Question: In a single sentence, describe what this figure presents.
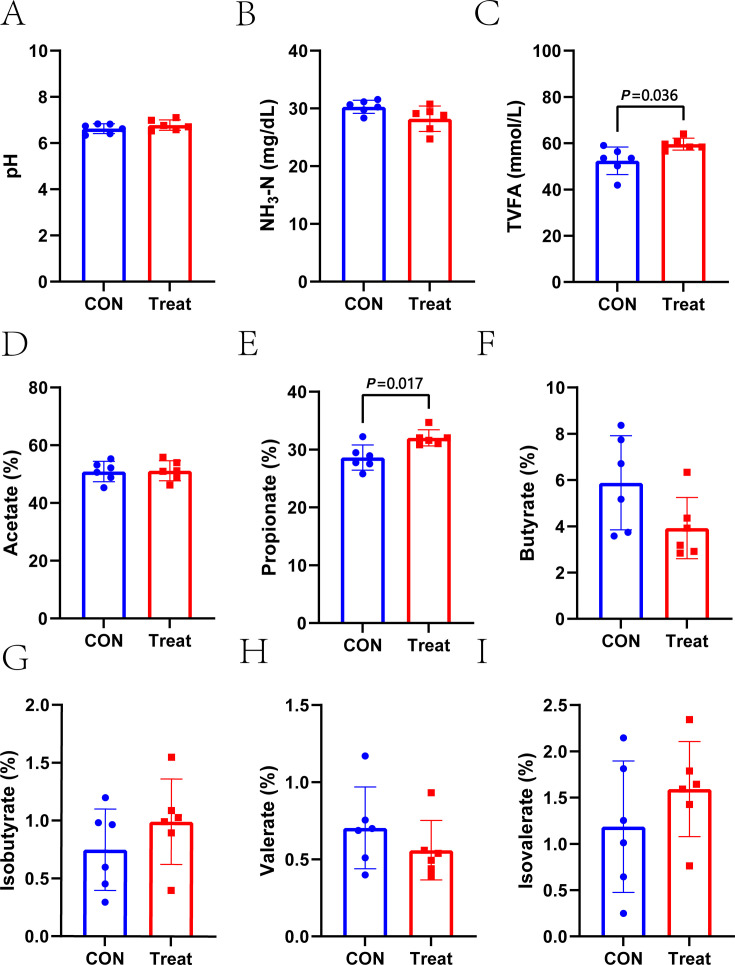
Answer: Effects of supplemental fermented Chinese herbal medicine on rumen fermentation parameters in lambs. Data are presented as mean ± SEM. Group comparisons were analyzed using an independent samples t -test. Nine bar graphs comparing rumen fermentation parameters between control and treated lambs. ( A ) pH; ( B ) NH₃-N; ( C ) TVFA; ( D ) Acetate; ( E ) Propionate; ( F ) Butyrate; ( G ) Isobutyrate; ( H ) Valerate; ( I ) Isovalerate. Fermented Chinese herbal medicine significantly increased TVFA ( P = 0.036) and propionate percentage ( P = 0.017). Other parameters showed no significant differences.